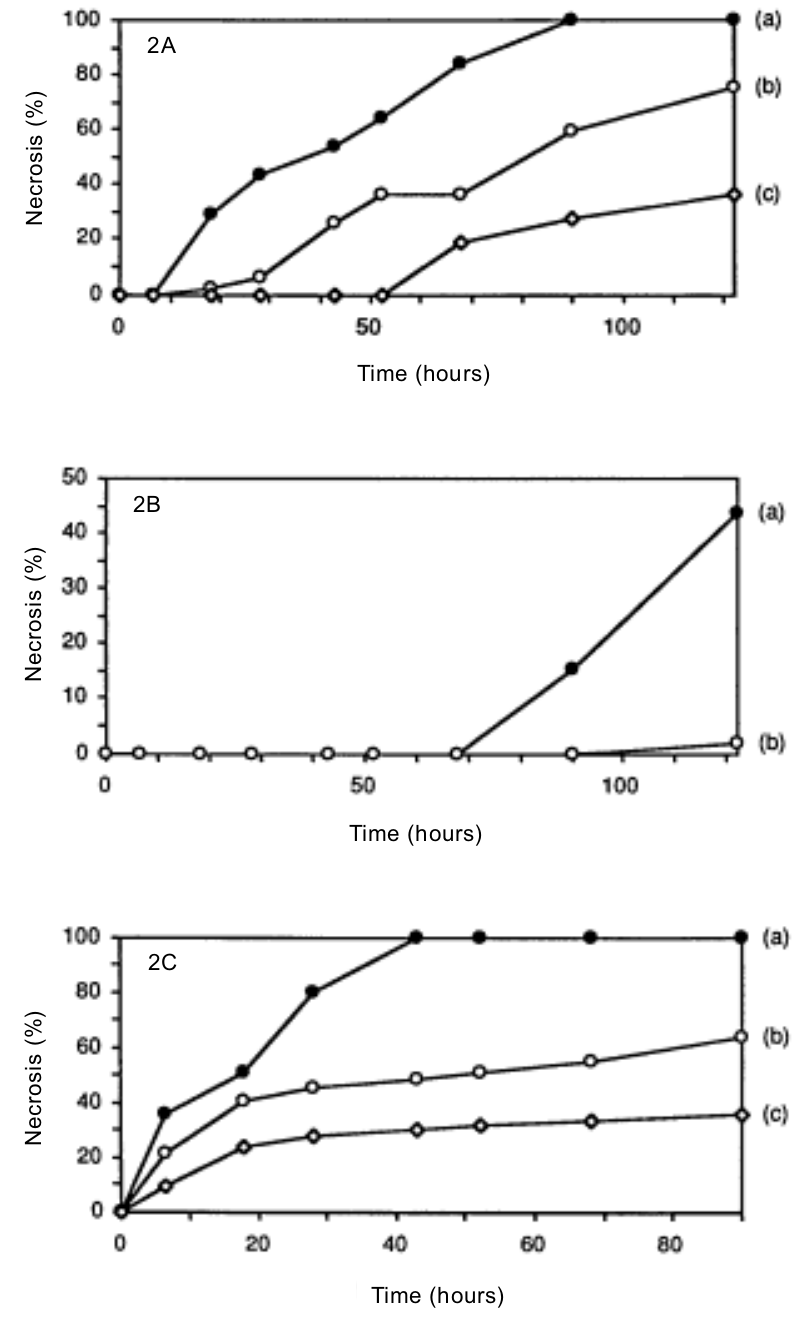
Fig. 2. Observed black areas (as % of total area) are shown as a function of time; biological tests were performed on 1 cm 2 pieces of plane tree leaves and controls were kept in 2% aqueous solutions of ethanol. 2A, PAB (10) solution at: (a)1000 ppm (7.2 µ M), (b) 500 ppm (3.6 µ M), and (c) 100 ppm (0.72 µ M); 2B, solution of a racemic mixture of 2,4,8- THN (1 and 2) at: (a) 1000 ppm (5.15 µ M), (b) 500 ppm (2.57 µ M); 2C, 2-HJ (11) solution at: (a) 500 ppm (2.63 µ M), (b) 100 ppm (0.52 µ M), and (c) 50 ppm (0.26 µ